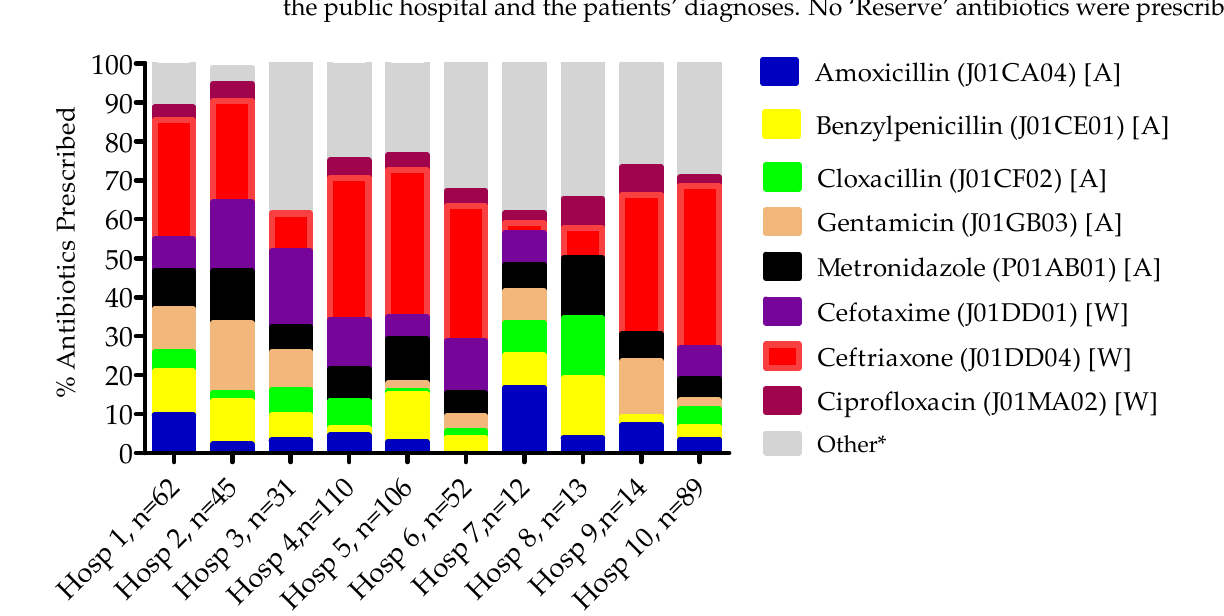
Figure 1. Commonly prescribed antibiotics at the hospital level. Key: * Other antibiotics prescribed include ampicillin, azithromycin, co-trimoxazole, erythromycin, meropenem, nitrofurantoin, and penicillin-V; A = Access, W = Watch. Patients could be prescribed more than one antibiotic.